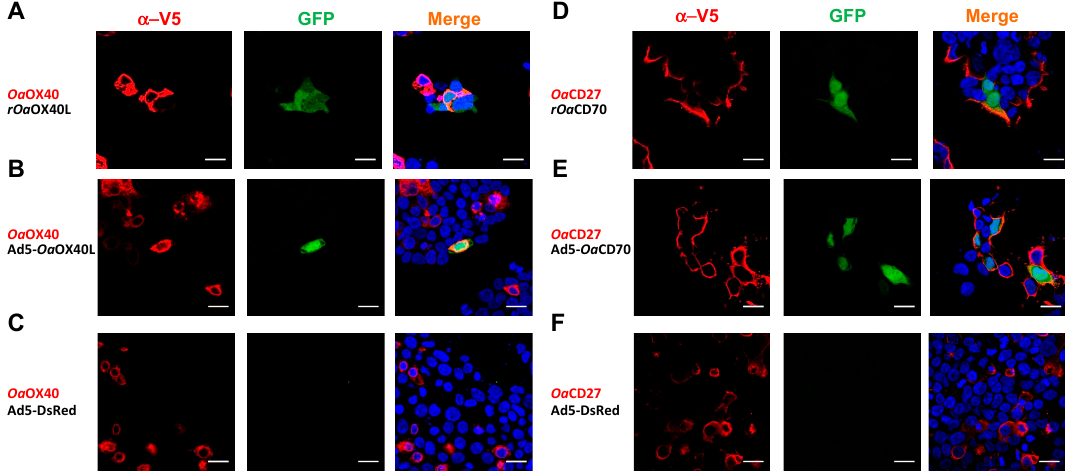
Figure 5. The r Oa OX40L and r Oa CD70 specifically elicit signalling through their cognate receptors Oa OX40 and Oa CD27. HEK293-pr(IFNB)-GFP cells were transfected with, ( A – C ) Oa OX40-V5 and ( D – F ) Oa CD27-V5. At 24 h post transfection, the cells were stimulated with 10 μ g of purified (A) rOa OX40L or (D) rOa CD70 proteins, or equivalent amounts of conditioned media from Ad5- Oa OX40L (B) rOa OX40L, (E) Ad5- Oa CD70, or (C,F) Ad5-DsRed infected Vero cells proteins in conditioned media from Ad5- Oa OX40L, Ad5- Oa CD70, or Ad5-DsRed infections. At 16 h post stimulation, the cells were fixed and an immunofluorescence using anti-V5 (red) to detect the transfected receptors was performed. GFP (green) activity was detected by fluorescence microscopy and DAPI was used to counterstain cells to nuclei (blue). Bars = 20 μ m.